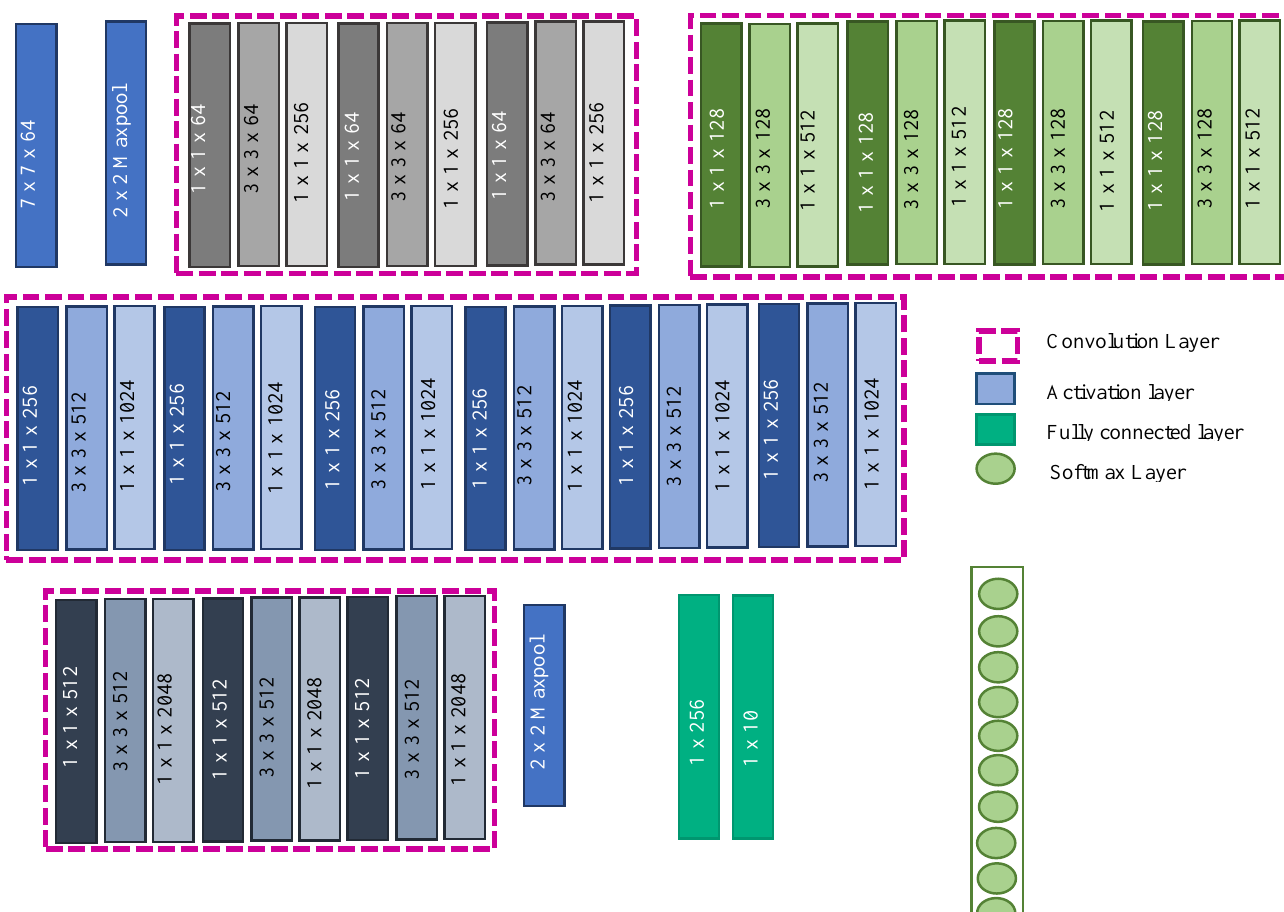
Fully connected